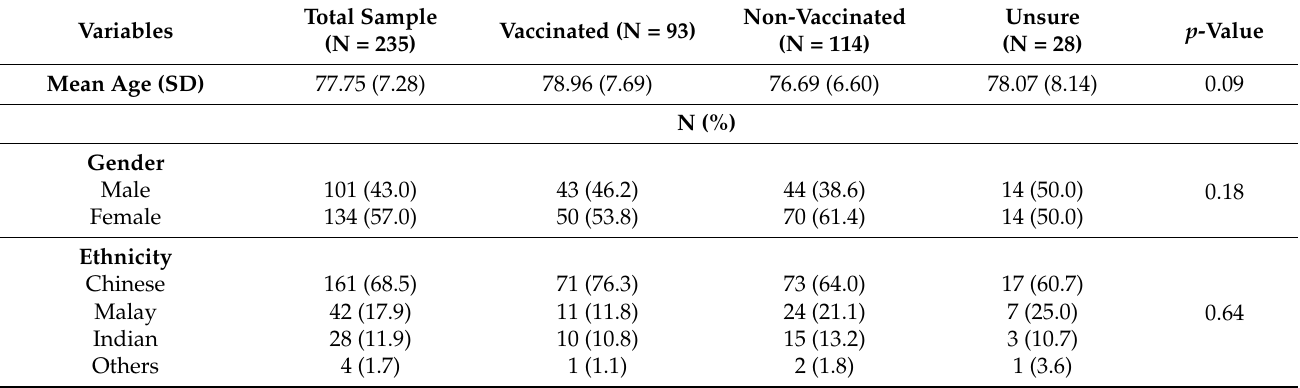
Table 1. Descriptive demographics and their association with vaccination status (N =